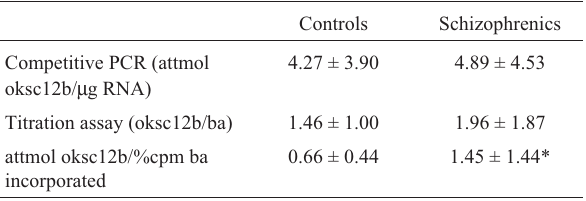
Table 1 - Assessment of the oksc12b gene expression after RT-PCR assays of RNA from lymphocytes of control subjects and schizophrenic